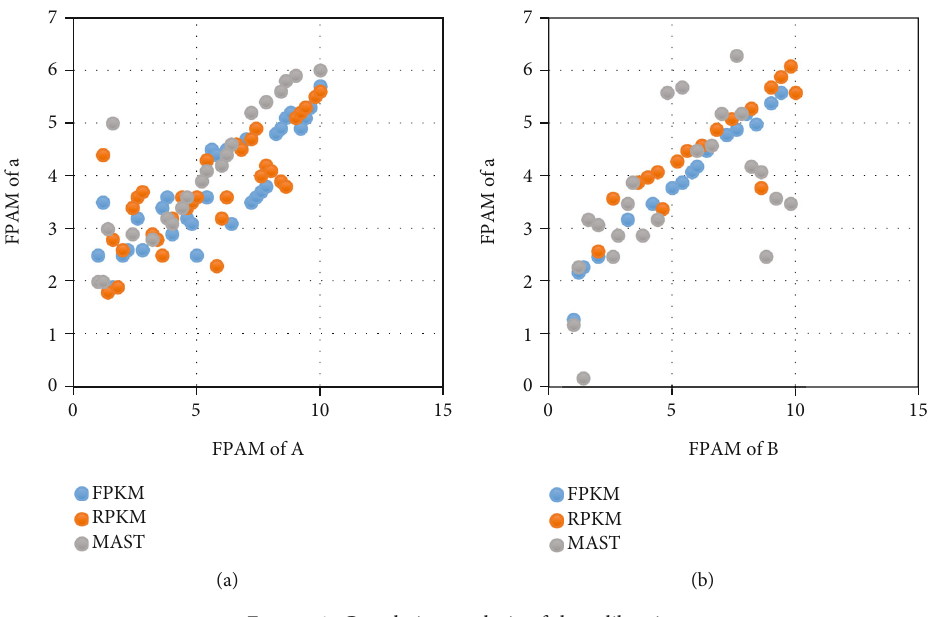
Figure 9: Correlation analysis of three libraries.